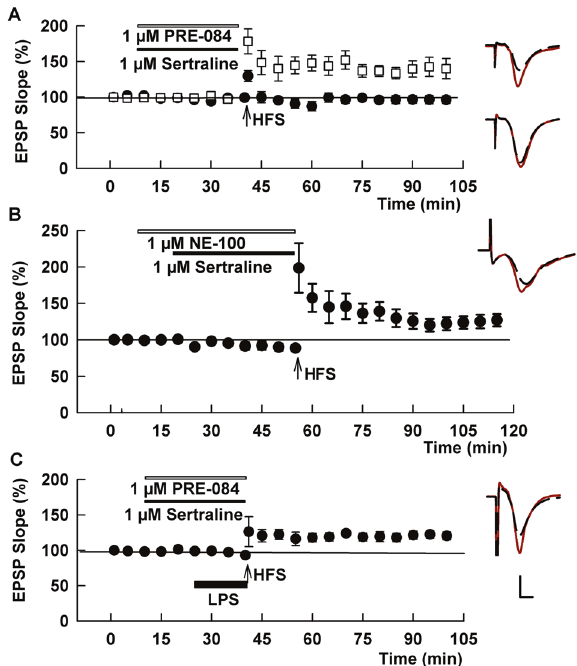
Fig. 5 The SSRI sertraline acutely inhibits LTP in contrast to fl uvoxamine and fl uoxetine. A At 1 μ M, sertraline blocked the ability of a single HFS to induce LTP (black circles). This LTP inhibition was overcome by the S1R antagonist, PRE-084 (white squares). B The S1R antagonist, NE-100 also overcame LTP inhibition by sertraline. C A combination of sertraline plus PRE-084 also allowed LTP in the presence of LPS. Traces show representative EPSPs. Calibration: 1 mV, 5